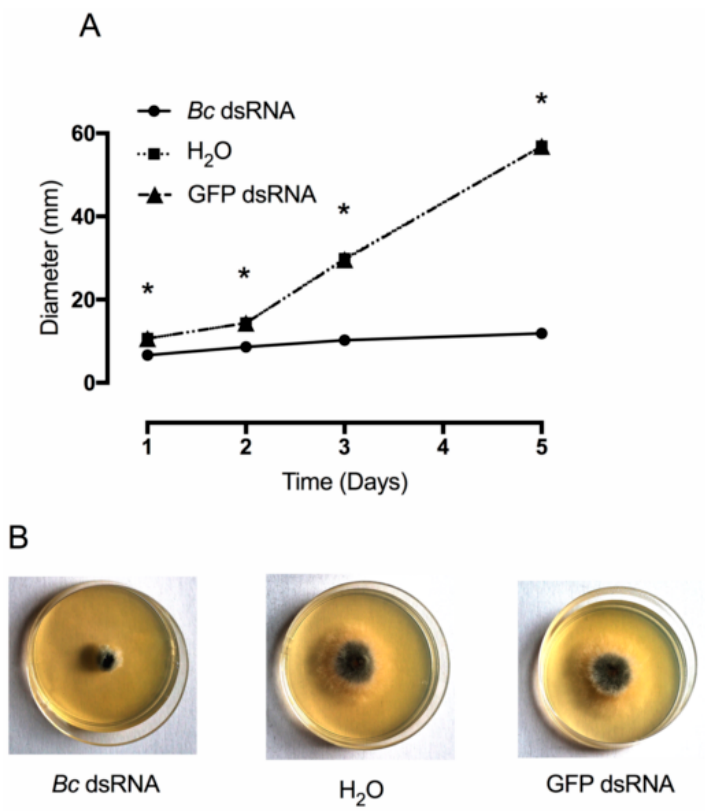
Figure 2. E ff ect of supplied dsRNAs in vitro. Growth of B. cinerea over time following the application of Bc dsRNA, GFP dsRNA, and H 2 O ( A ). Examples of fungal development in petri dishes in response to dsRNAs or H 2 O delivery at three days ( B ). Asterisks indicate significant di ff erences as determined by Tukey HSD test ( p ≤ 0.05).